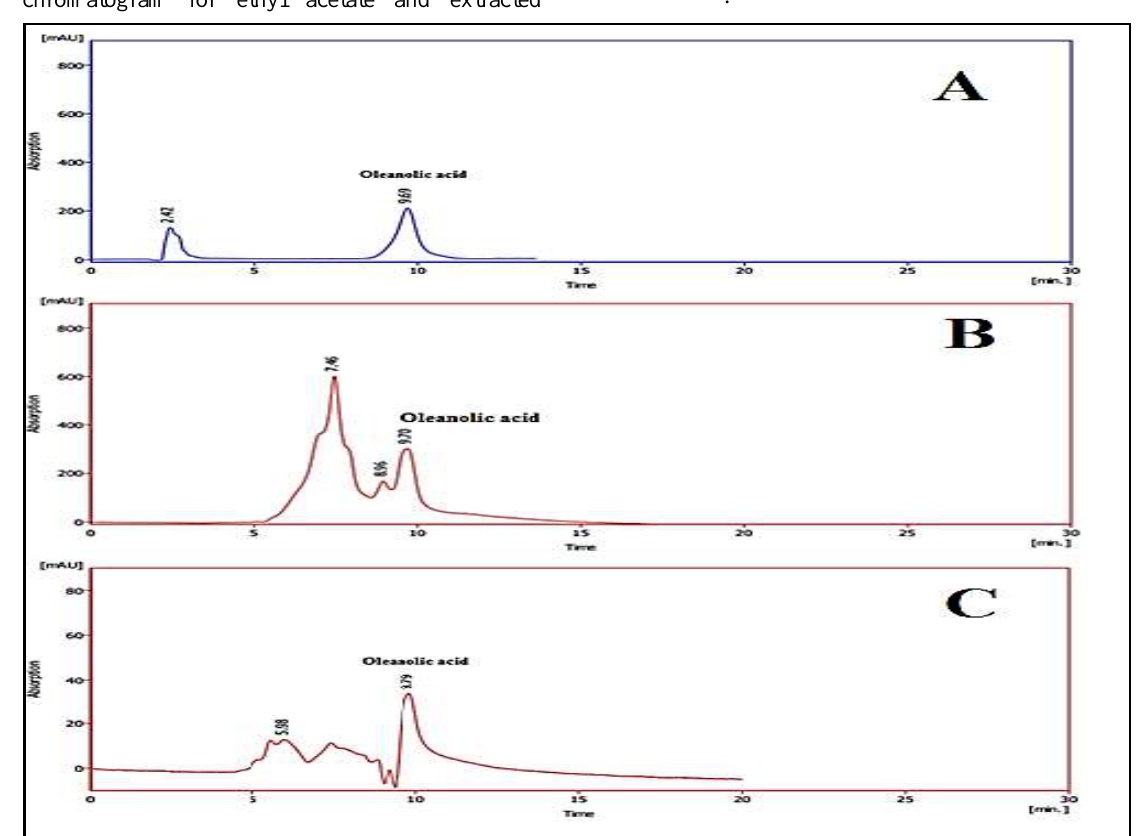
Figure 2. HPLC chromatogram of A: Standard oleanolic acid, B: Ethyl acetate fraction (method 1), C: extracted oleanolic acid fraction (method